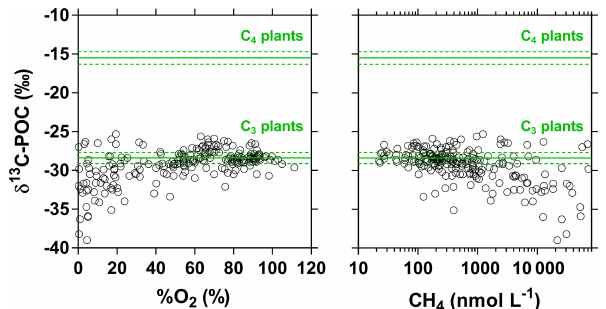
Figure 6. Carbon stable isotope composition of particulate organic carbon ( δ 13 C-POC in ‰) in surface waters of the Congo River net- work as a function of dissolved O 2 saturation level (%O 2 in %) and dissolved CH 4 concentration (nmolL − 1 ). Grey lines indicate average (full line) and standard deviation (dotted lines) of aver- age soil organic carbon stable isotope composition with a domi- nance of C 4 ( − 15 . 5 ± 0 . 8‰) and C 3 plants ( − 28 . 4 ± 0 . 7‰) (Bird and Pousai, 1997). Data with δ 13 C-POC< − 30‰ were associated with significantly lower %O 2 and higher CH 4 than data with δ 13 C- POC> − 30‰ (Mann–Whitney p< 0 . 0001 for both